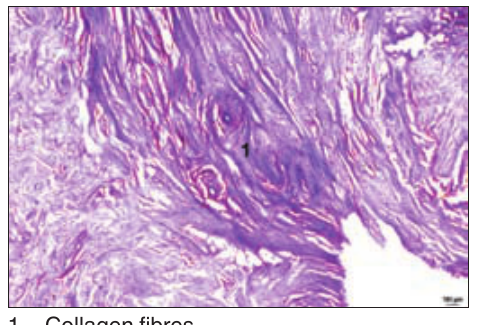
Fig. 7. Longitudinal section of cervix. Pas mc manus method x 400